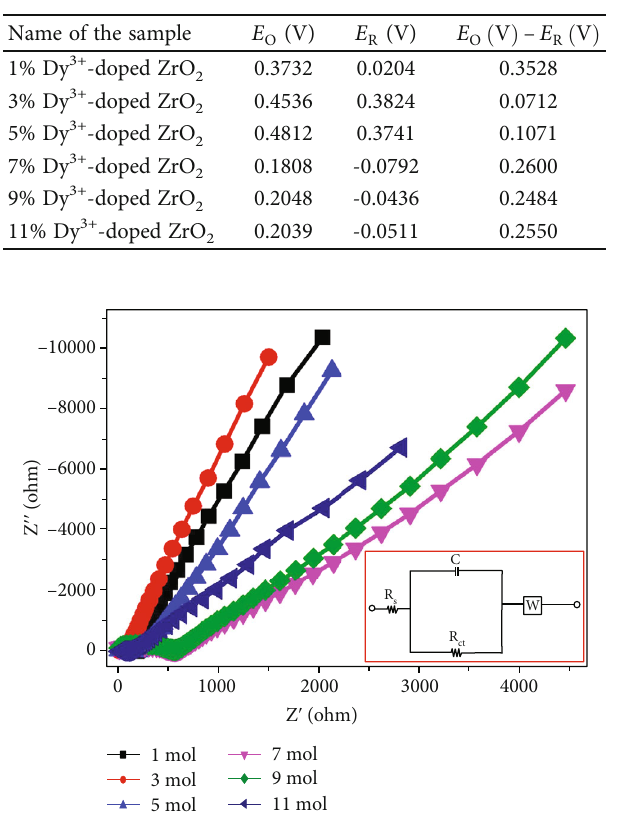
Figure 12: Nyquist plots of Dy 3+ -doped ZrO electrodes.